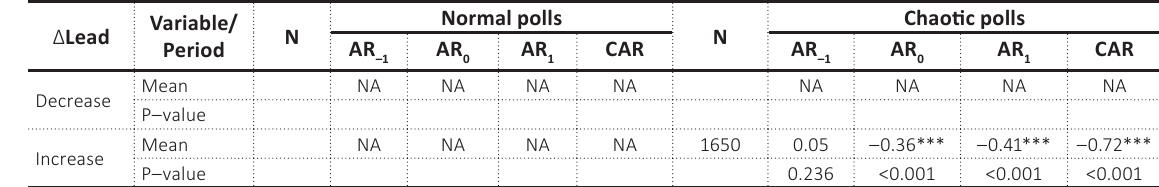
Panel B. CAR for normal and chaotic